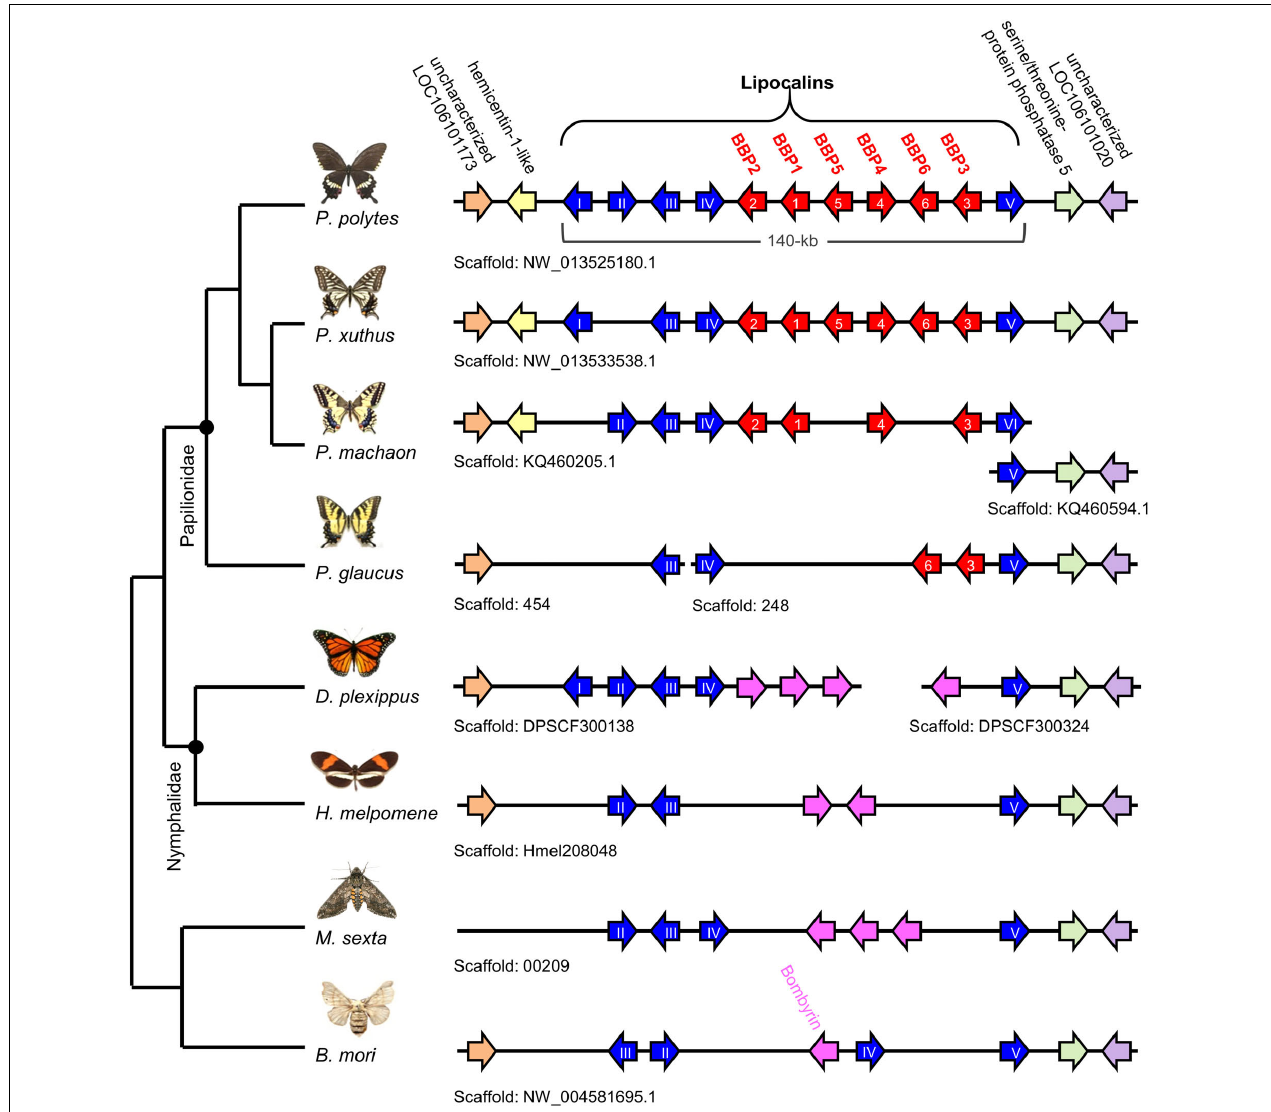
FIGURE 4 | Clustered structure of lipocalin family genes among lepidopteran species. Based on the whole-genome sequence of each species, the location and gene direction for each BBP gene (red arrow) and lipocalin gene (blue arrow) are shown. Lipocalin genes conserved among taxa other than Papilio species (Bombyrin) are shown by pink arrows. Genes conserved among Lepidoptera are shown as orange, yellow, green, and purple arrows which are used for landmarks to validate whether these loci are orthologous to the P. polytes . Note that BBP genes (red arrows) are conserved only in Papilio species. Lipocalin type is based on phylogenetic analysis in Supplementary Figure S3